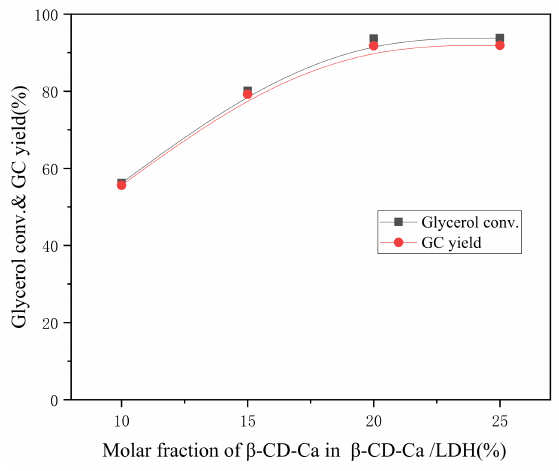
Figure 6. Effect of β -CD-Ca dosage on glycerol conversion and GC